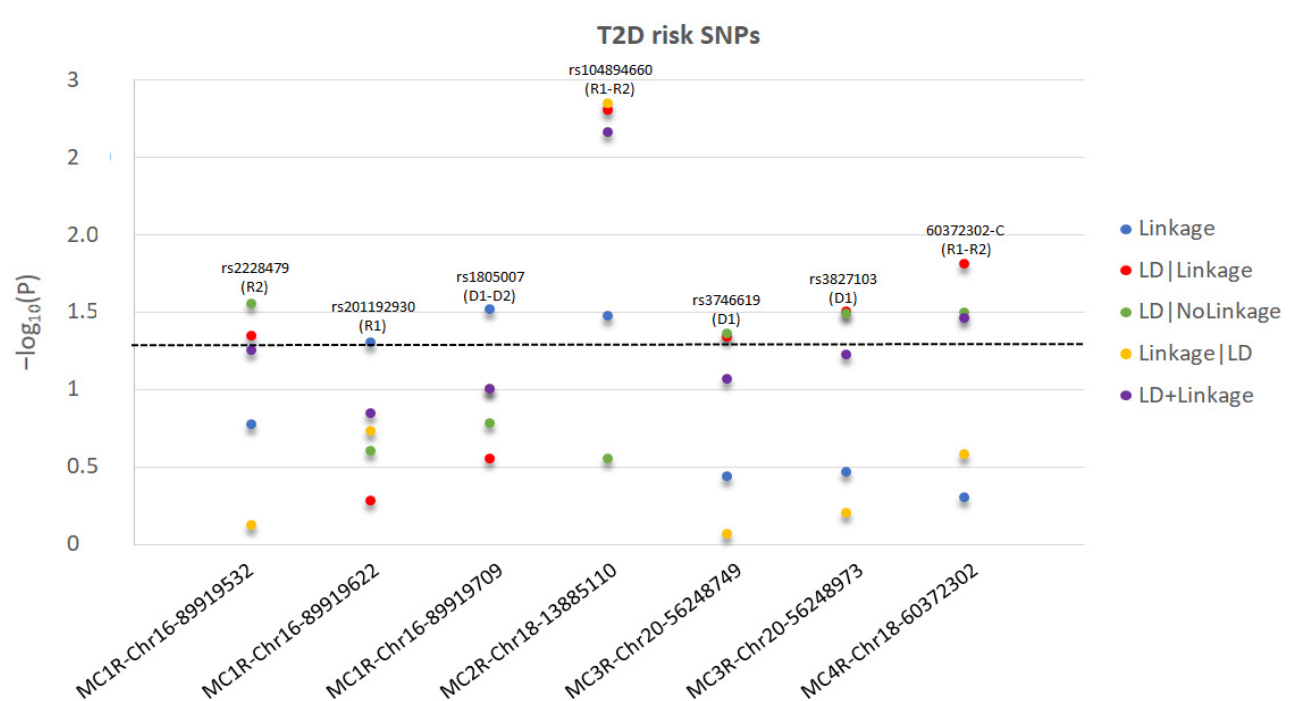
Figure 1. For each significant T2D-risk SNP in MC2R - MC4R genes, we present the − log 10 (P) as a function of each test statistic (Linkage, LD|Linkage, LD|NoLinkage, Linkage|LD, and LD+Linkage) and label the significant inheritance model: D1: dominant, complete penetrance; D2: dominant, incomplete penetrance; R1: recessive, complete penetrance; R2: recessive, incomplete penetrance. For MC1R -rs1805007, the most significant test statistics between D1 and D2 are presented. For MC2R -rs104894660, the most significant test statistics between R1 and R2 are presented. For MC4R -60372302-C, R2 test statistics are presented as more significant than R1. The level of statistical significance is marked by the dotted line.